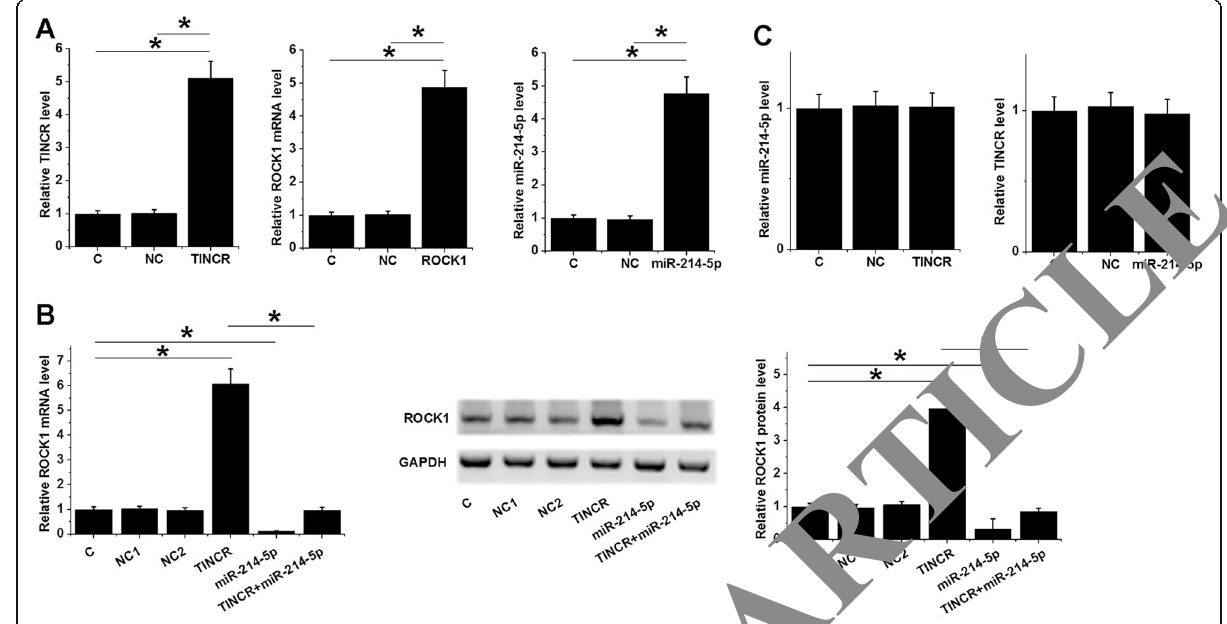
Fig. 4 The interactions among TINCR, ROCK1 and miR-214-5p in HCC cells. TINCR and ROCK1 expression vectors as well as miR-214-5p mimic were transfected into H1581 cells. At 24 h post-transfection, overexpression of TINCR, ROCK1 and miR-214-5p was confirmed by qPCR ( a ). The effects of TINCR and miR-214-5p on ROCK1 overexpression were analyzed by qPCR and western blot ( b ). The interaction between TINCR and miR-214-5p was analyzed by qPCR ( c ). All experiments were repeated 3 times and mean values were presents. NC1, empty vector transfection; NC2, negative control miRNA transfection (*, p < 0.05)